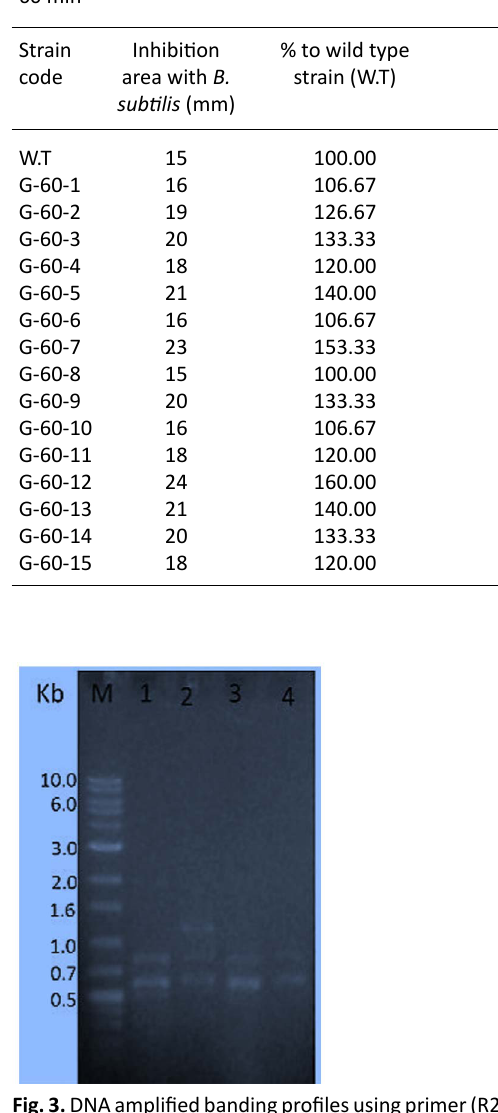
Table 5. Neomycin production of different mutants obtained under 1.75 mg/ml neomycin stress and treatment of S. albogriseolus with 100 µg/ml NTG for